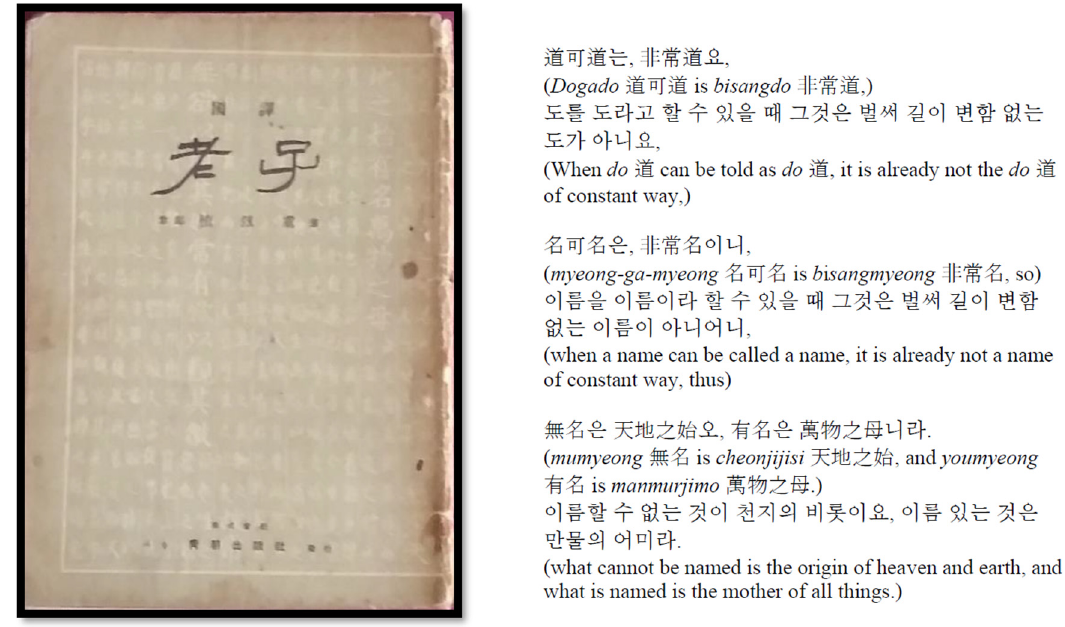
Figure 1. The first translation of Laozi in Korean with Hyunto after liberation from